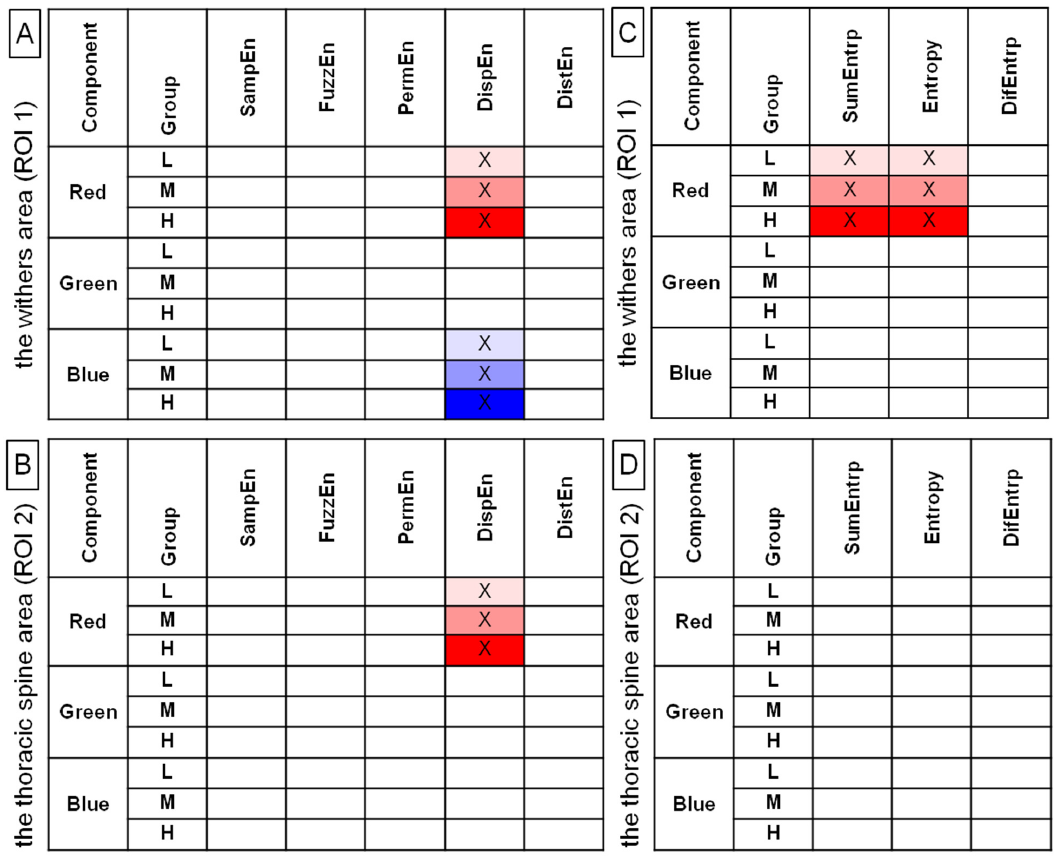
Figure 10. Entropy measures ( A , B ) and selected gray-level run-length matrix features ( C , D ) for examined color components (red, green, blue), which were considered to increase in a similar way throughout the light (L), moderate (M), and heavy (H) rider groups on the post-exercise imaging. Data were presented separately for the withers area (ROI 1) ( A , C ) and the thoracic spine area (ROI 2) ( B , D ). SampEn—two-dimensional sample entropy, FuzzEn—two-dimensional fuzzy entropy, PermEn—two-dimensional permutation entropy, DispEn—two-dimensional dispersion entropy, DistEn—two-dimensional distribution entropy, SumEntrp—summation entropy, entropy, DifEntrp— differential entropy. The similar measures were marked by color (light red, green, blue for L group; moderate red, green, blue for M group; and dark red, green, blue for H group) and by a cross